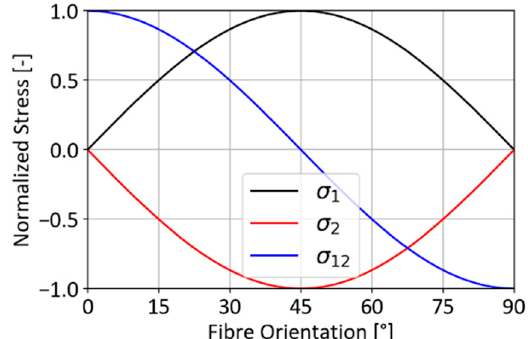
Figure 10. Normalized variation of local stress components after application of pure shear load on a laminate with given fiber orientation.